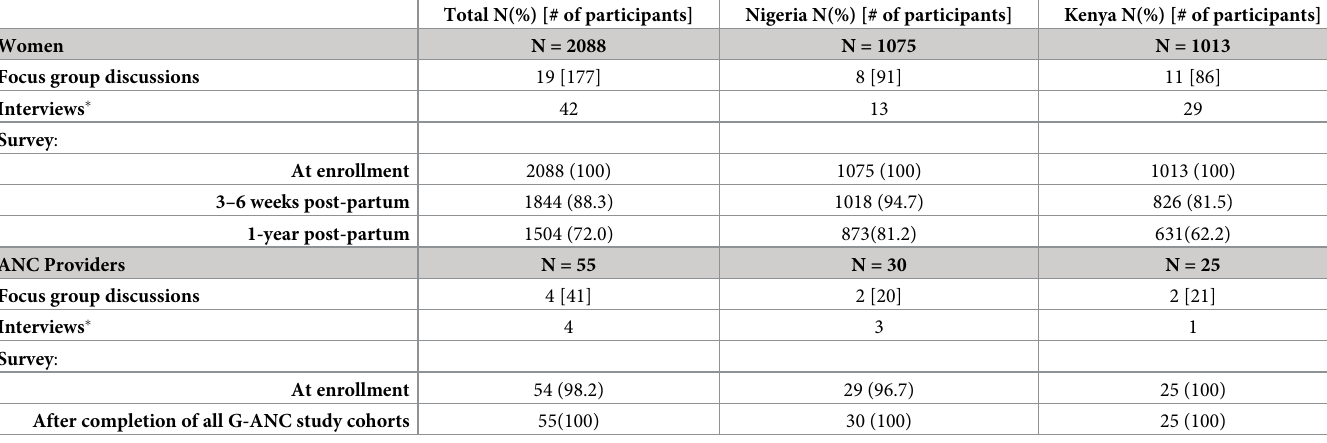
Table 2. Qualitative and quantitative data collection by